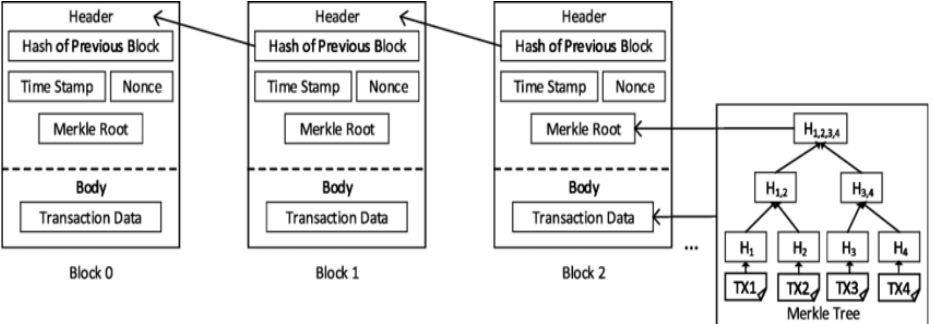
Figure 2. Structure of